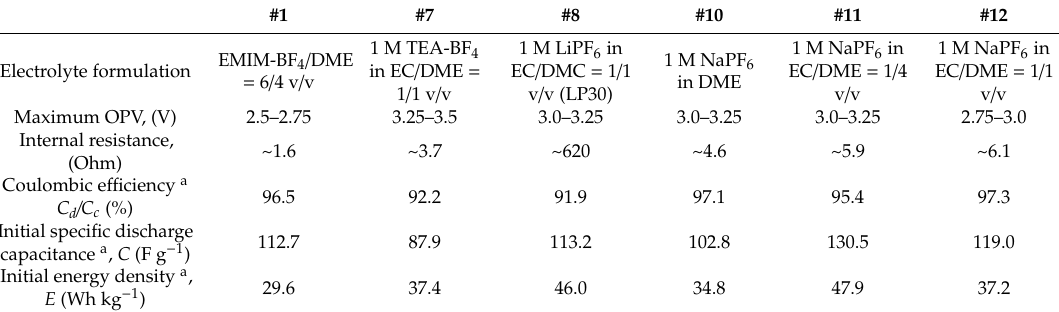
Figure 5. The initial charging–discharging curves at different current rates of EDLCs with electrolytes ( a ) #1, EMIM–BF 4 /DME = 6/4 v/v, ( b ) #8, 1 M LiPF 6 in EC/DMC = 1/1 v/v (LP30), ( c ) #7, 1 M TEA–BF 4 in EC/DME = 1/1 v/v, ( d ) #12, 1 M NaPF 6 in DME/EC = 1/1 v/v, ( e ) #11, 1 M NaPF 6 in DME/EC = 4/1 v/v, and ( f ) #10, 1 M NaPF 6 in DME. Table 5. Summary of the electrochemical properties of the EDLC cells with different electrolyte formulations.